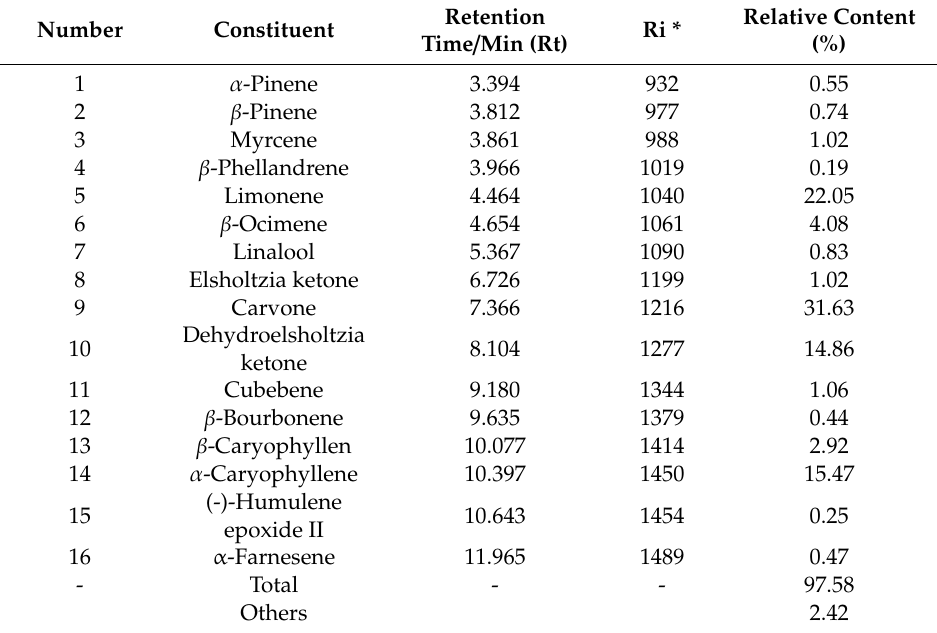
Table 1. Chemical composition of the essential oil from E. ciliata